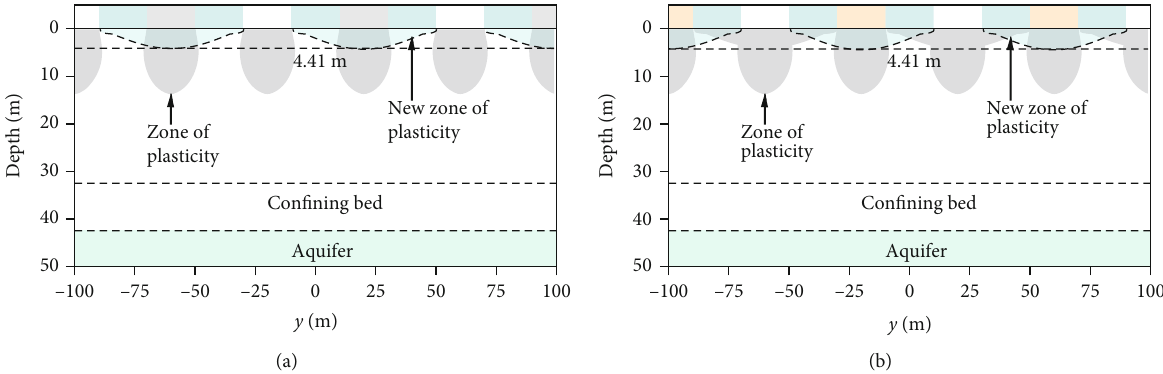
Figure 12: Plastic zone distributions of replacement mining fl oor: (a) fi rst back fi ll replacement mining; (b) second back fi ll replacement mining.